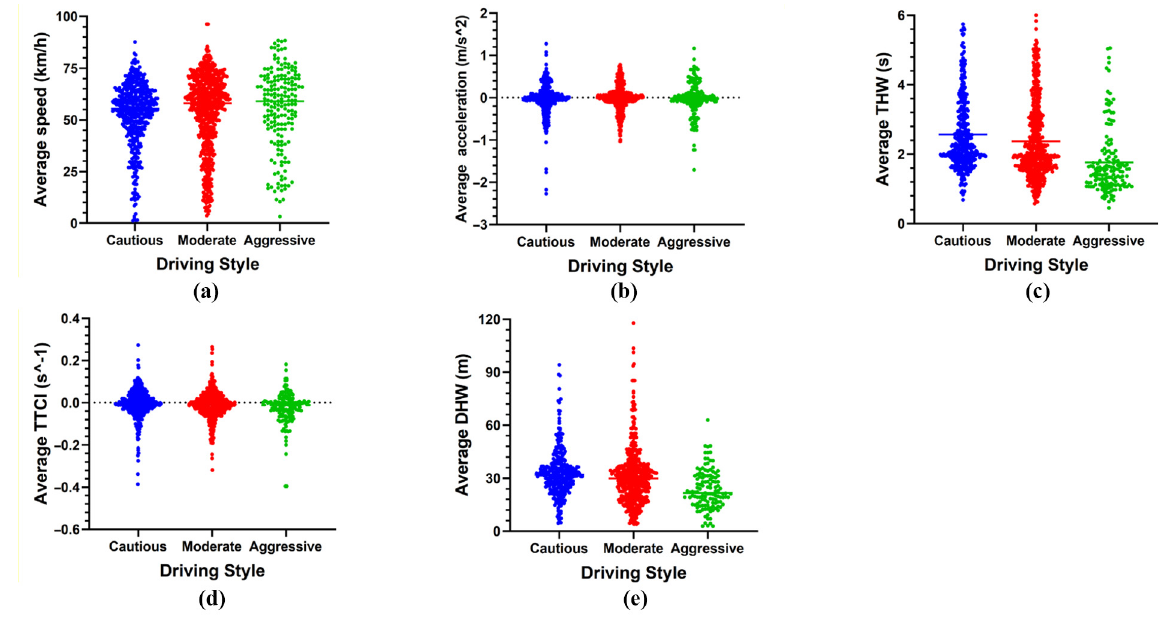
Figure 11 Data scatter diagram of longitudinal DOCs of drivers with different driving styles